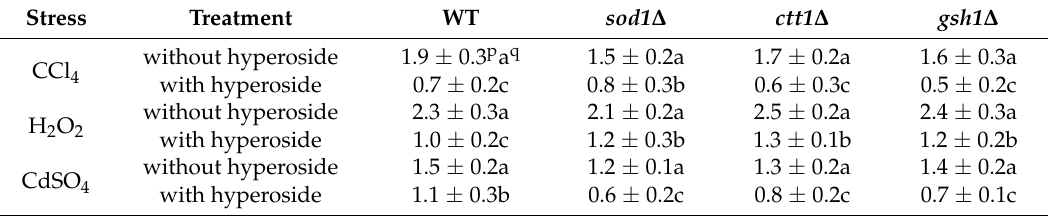
Table 2. Effect of 20 mg/L hyperoside on membrane lipid peroxidation in yeast cells.